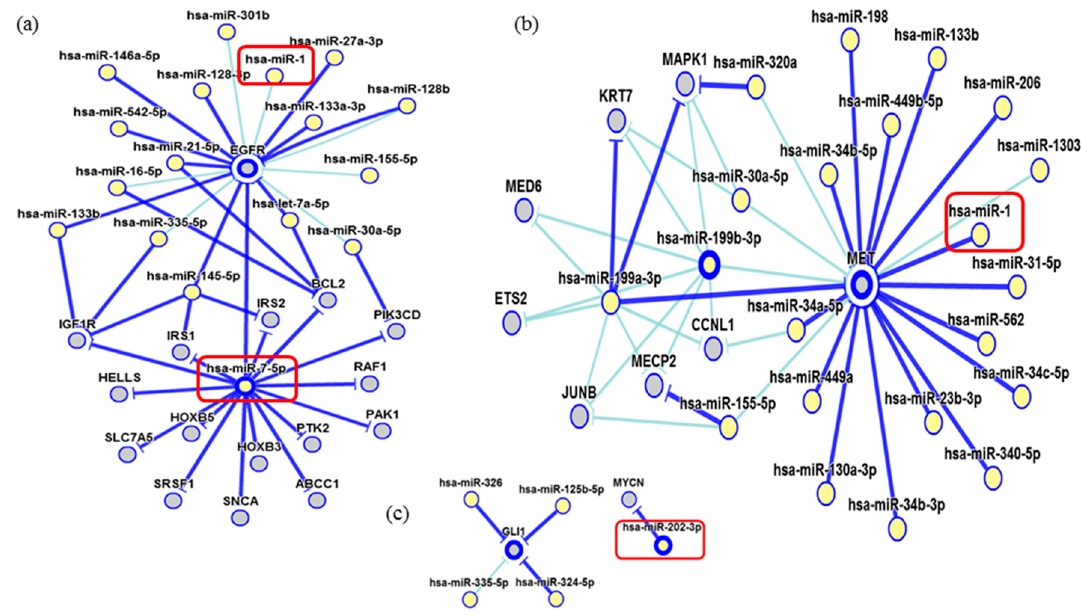
Figure 7. Interaction network of miR-7-5p and miR-1. ( a ) The miR-7-5p strongly modulates the EGFR, IGF1R, RAF1, and BCL2 genes while the miR-1 showed a weak interaction; ( b ) The miR-1 has a strong interaction with MET; ( c ) miR-202 showing a strong interaction with MYCN. In dark blue: strong evidence (reporter assay, Western blot, qRT-PCR, or qPCR) and, light blue, other evidence.